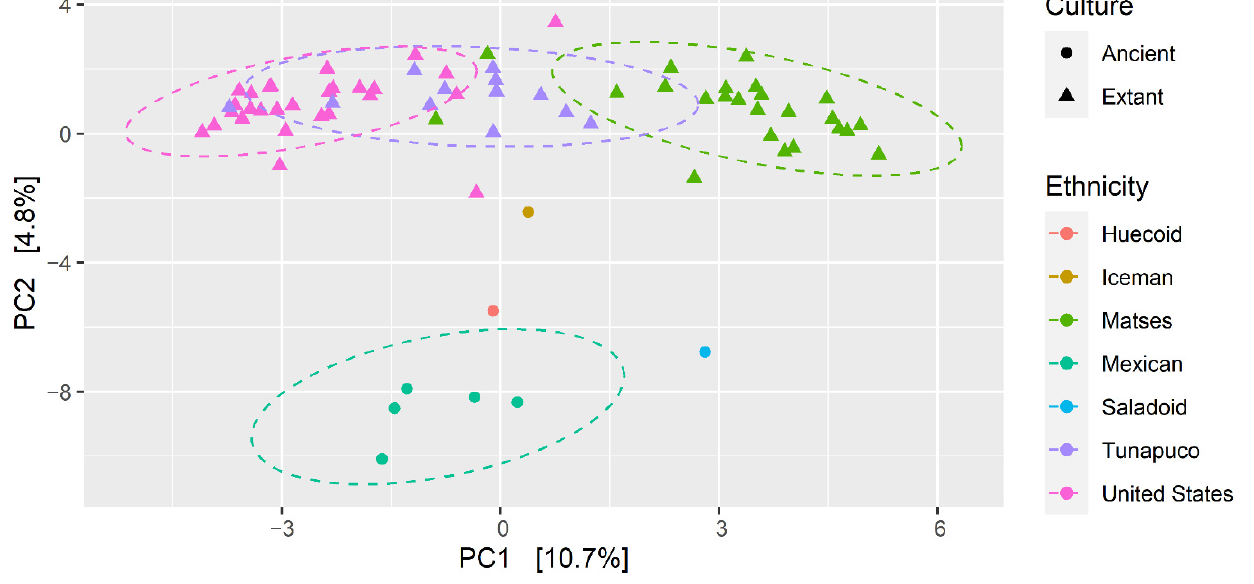
Figure 4. Beta-diversity comparisons of the gut mycobiomes of each ethnic group, principal coordinate analysis of Aitchison distances. The colors of the dots represent the different groups analyzed, whereas the symbols represent the ancient and extant cultures according to the legend. Symbols indicate whether cultures are ancient or extant.